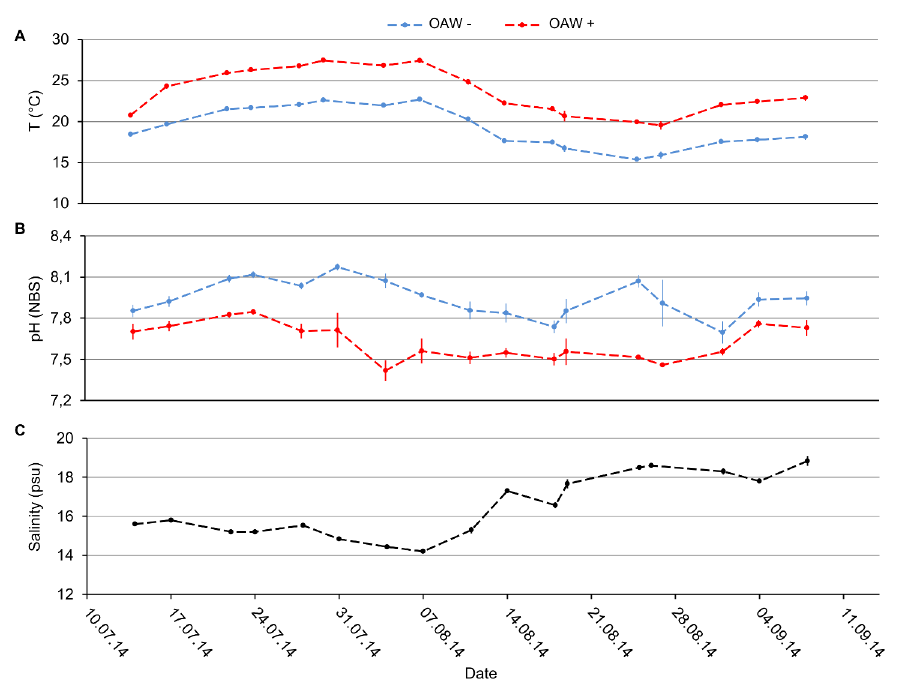
Fig 1. Temperature, pH and salinity during the OAW x nutrient experiment. ( A ) Temperature (°C), ( B ) pH (NBS, National Bureau of Standards) under the two treatment combinations ambient (OAW-), warmed and acidified (OAW+) and ( C ) salinity (psu) at the ambient treatment (OAW-). Data are the mean ± SD of three replicates in each treatment